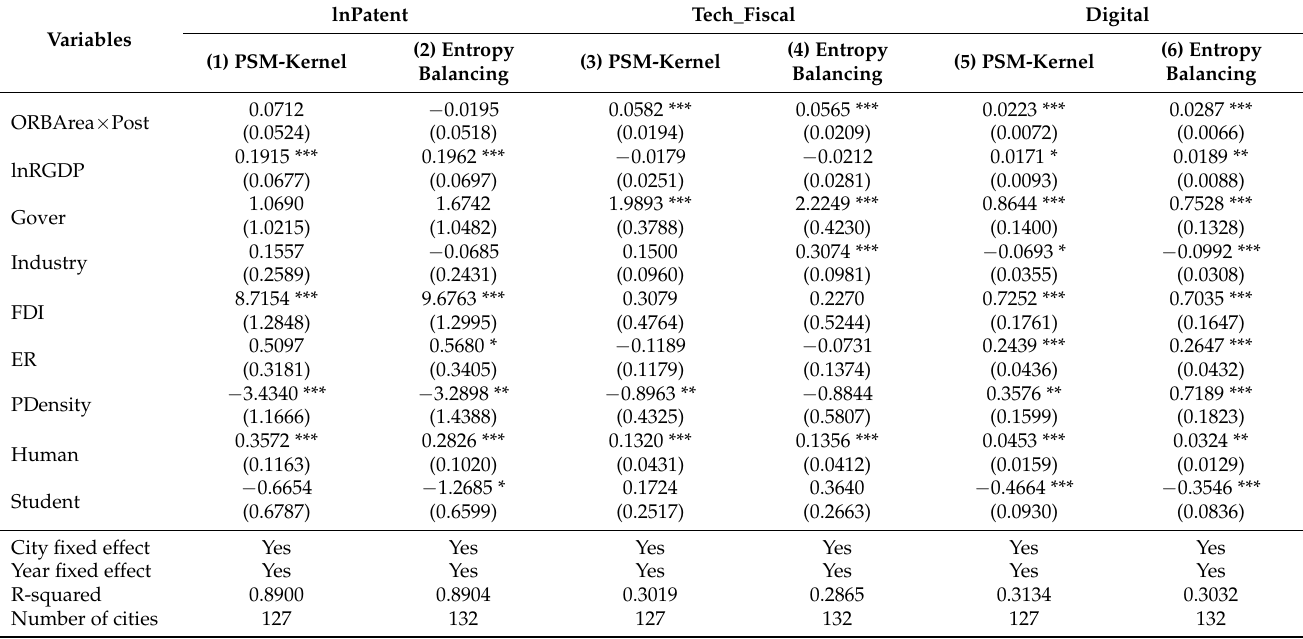
Table 9. Empirical results of the innovation effect